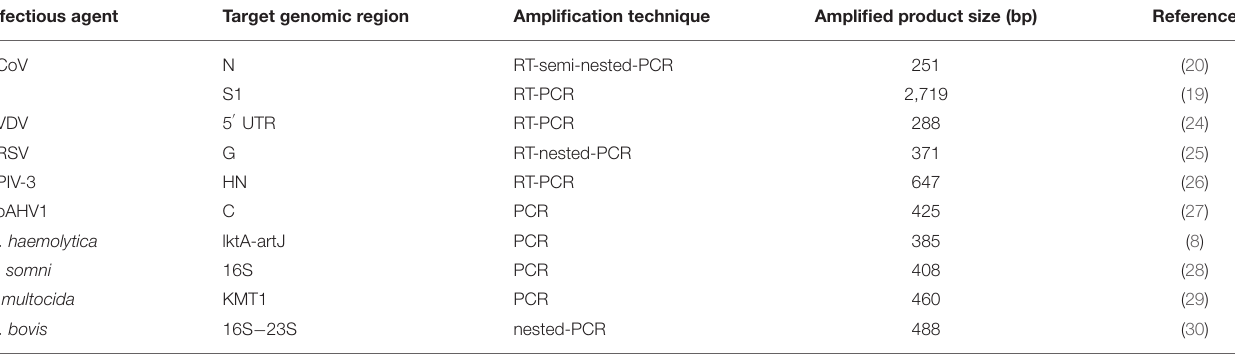
TABLE 1 | Target genomic region, amplification techniques and amplified product size to detect respiratory infectious agents in nasal swab samples of dairy heifer calves. Infectious agent